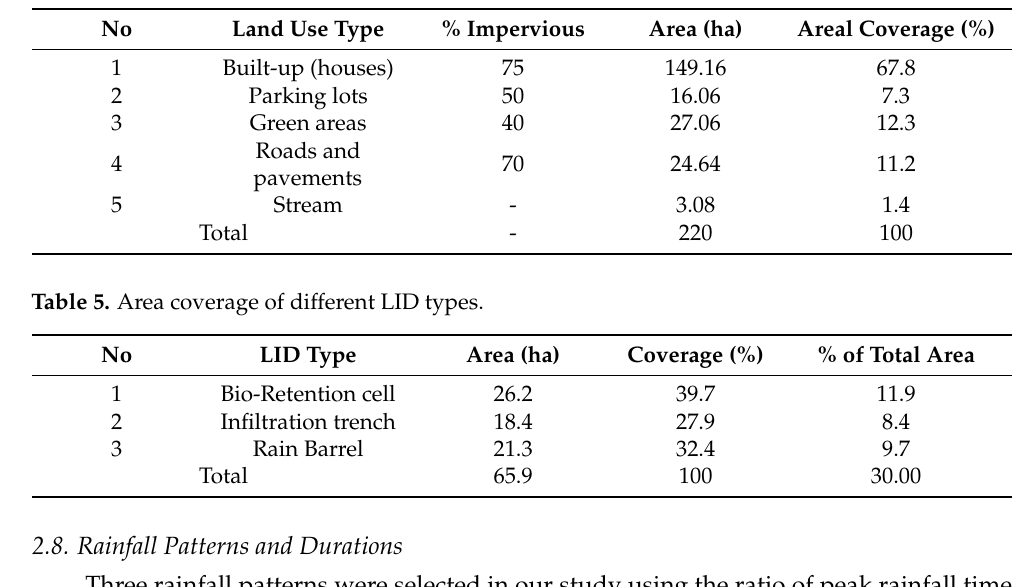
Table 5. Area coverage of different LID types.